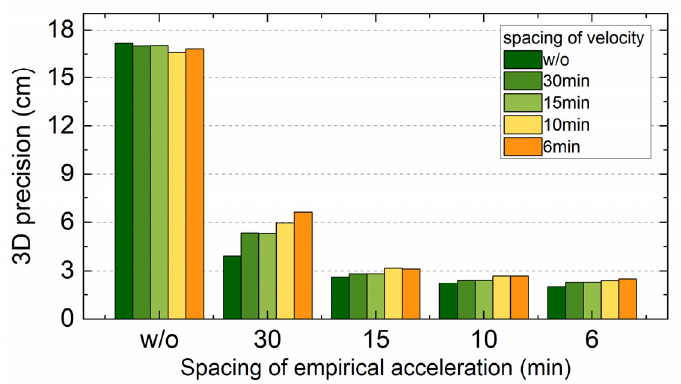
Figure 12. The 3D precision of Luojia-1A with di ff erent settings for the pseudo-stochastic parameters.